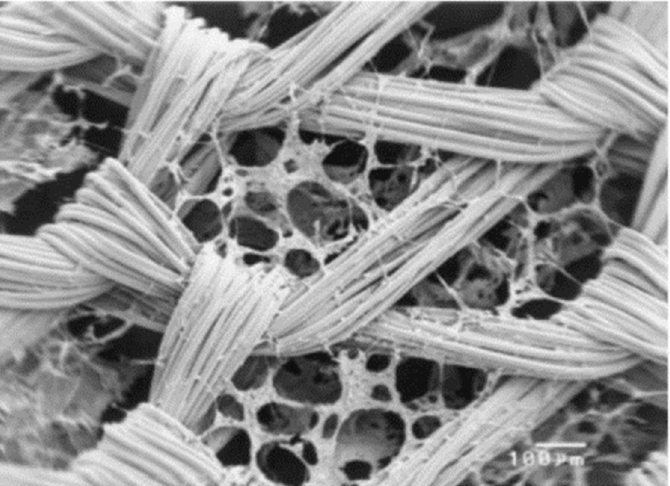
Figure 4. SEM photomicrograph of knitted non-woven polyglactin (PLGA) fiber/collagen composite scaffold (scale bar is 100 µm). Reprinted with permission from [60]. Copyright 2003, Wiley Periodicals, Inc., Hoboken, NJ,